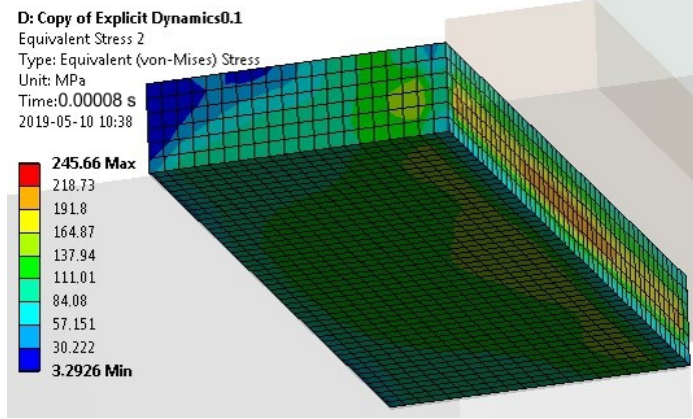
Figure 13. The von Mises Stress in the upper element of the specimen for a computation time equal to 0.00008 s—Model no. 1 (linear analysis).